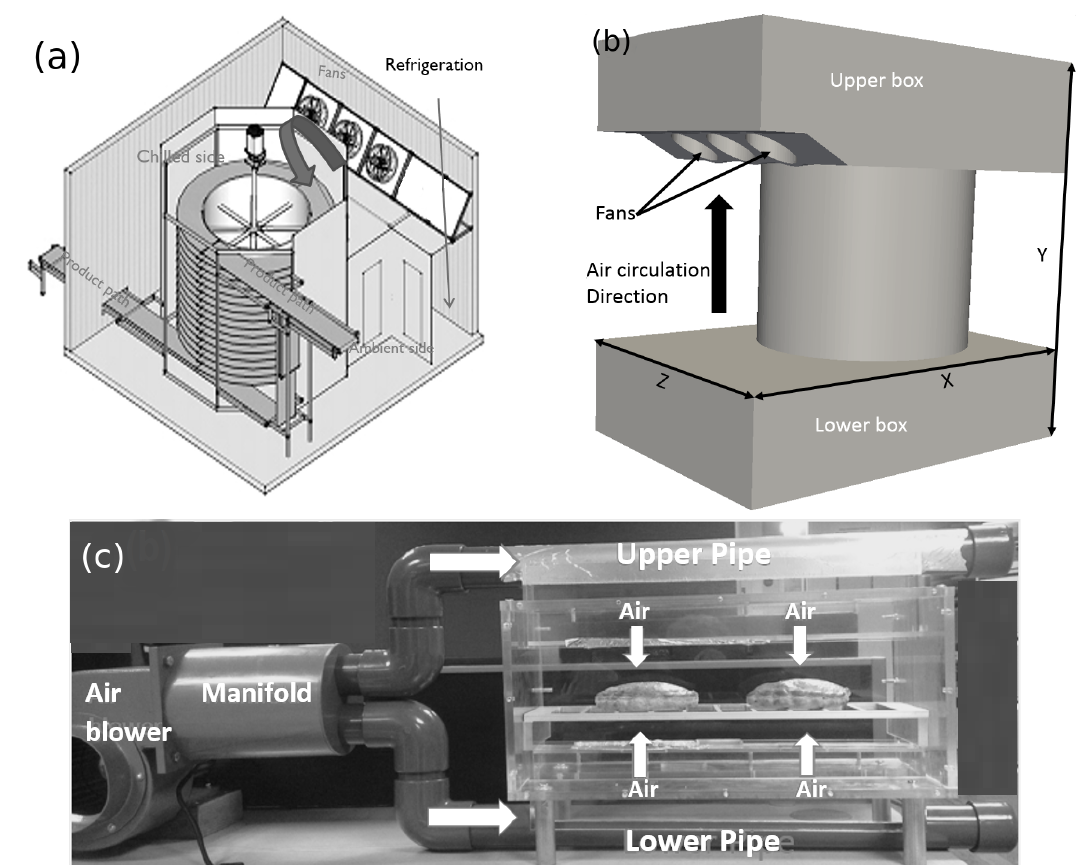
Figure 1. Experimental setups to measure data for validation comparison. ( a ) shows a schematic of the air flow domain for the refrigeration spiral. The spiral comprises 15 complete revolutions, with 360 pasties are arranged on each tier (full revolution). The overall height of the spiral is 6 m. ( b ) shows the air flow domain as simulated in CFD. ( c ) shows a photograph of the experimental rig developed for measuring the core temperature of a singe